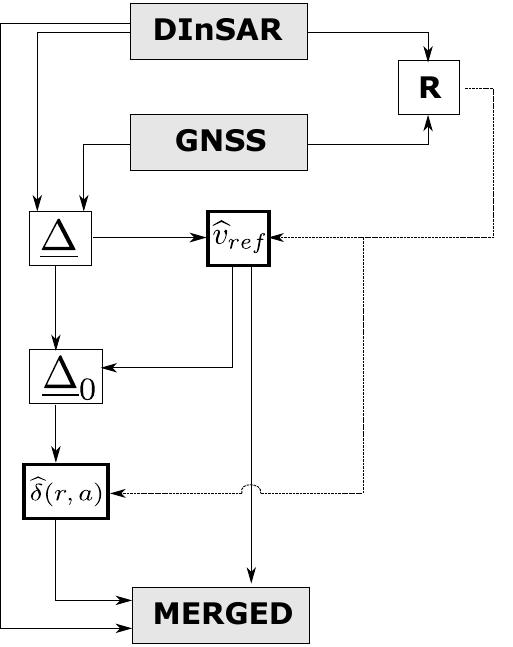
Figure 1. Flow chart of the proposed